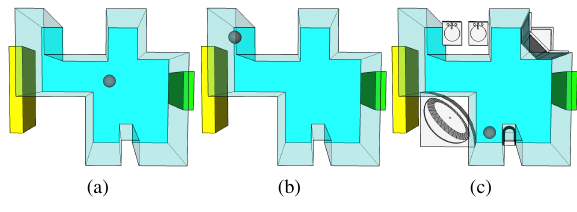
Figure 9. Example of different positions for a node of the same cell (a) Central position of the node. (b) Node placed at the closest corner to the window. (c) Node placed between two furnishing elements. Figure 10. Edges for the navigation graph. (a)The edge crosses the navigable cell and lay on a non-navigable one. (b) The non-navigable cell is bypassed through the use of multiple